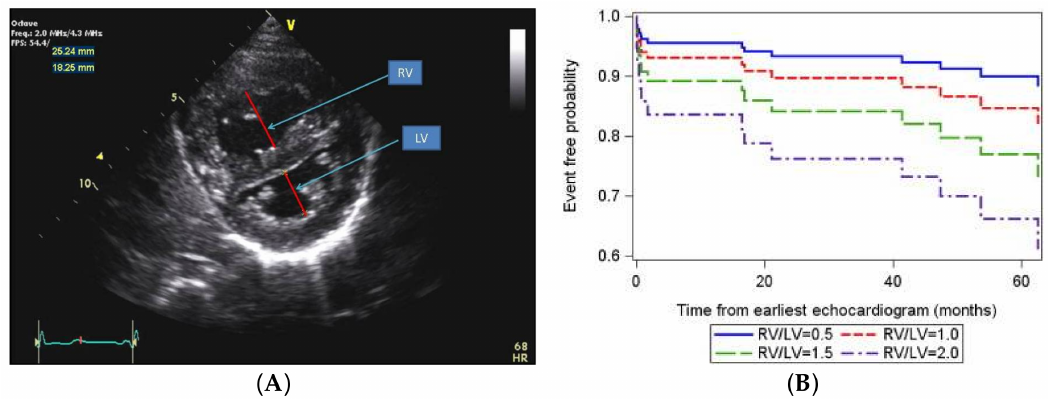
Figure 6. ( A ) Parasternal short axis view of the right and left ventricles (RV/LV) at the level of the papillary muscles. The RV/LV ratio is derived from RV diameter and LV diameter at end-systole. RV/LV end-systolic ratio is predictive of outcome; ( B ) Estimated survival curves for four possible RV/LV ratios estimated from the Cox varying coefficients regression corresponding to a hazard ratio of 2.49 for RV/LV ratio